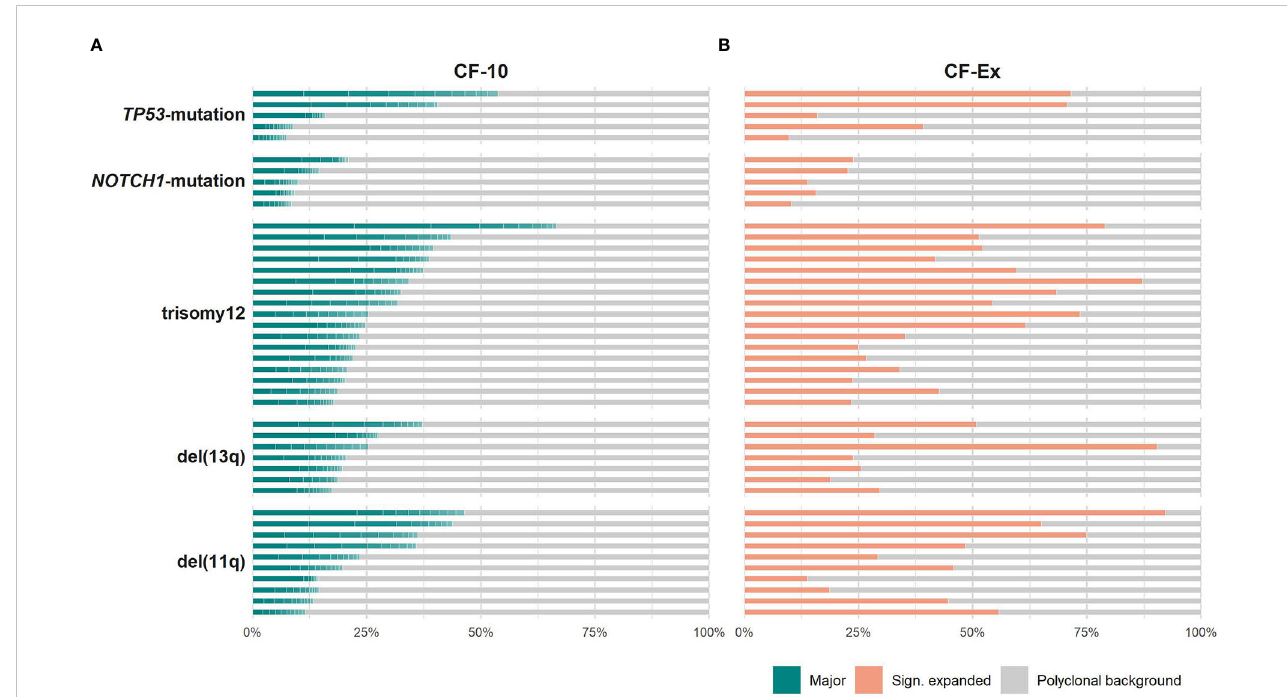
FIGURE 1 Clonality pro fi les of individual cases with CLL bearing distinct genomic aberrations. (A) Frequency (%) of the major clonotypes per sample of a given group. (B) Cumulative frequency (%) of the signi fi cantly expanded clonotypes per sample of a given group. Colored tiles depict each of the 10 major clonotypes within a sample and the fraction occupied by the signi fi cantly expanded clonotypes, respectively; the remaining clonotypes (polyclonal background) are depicted in